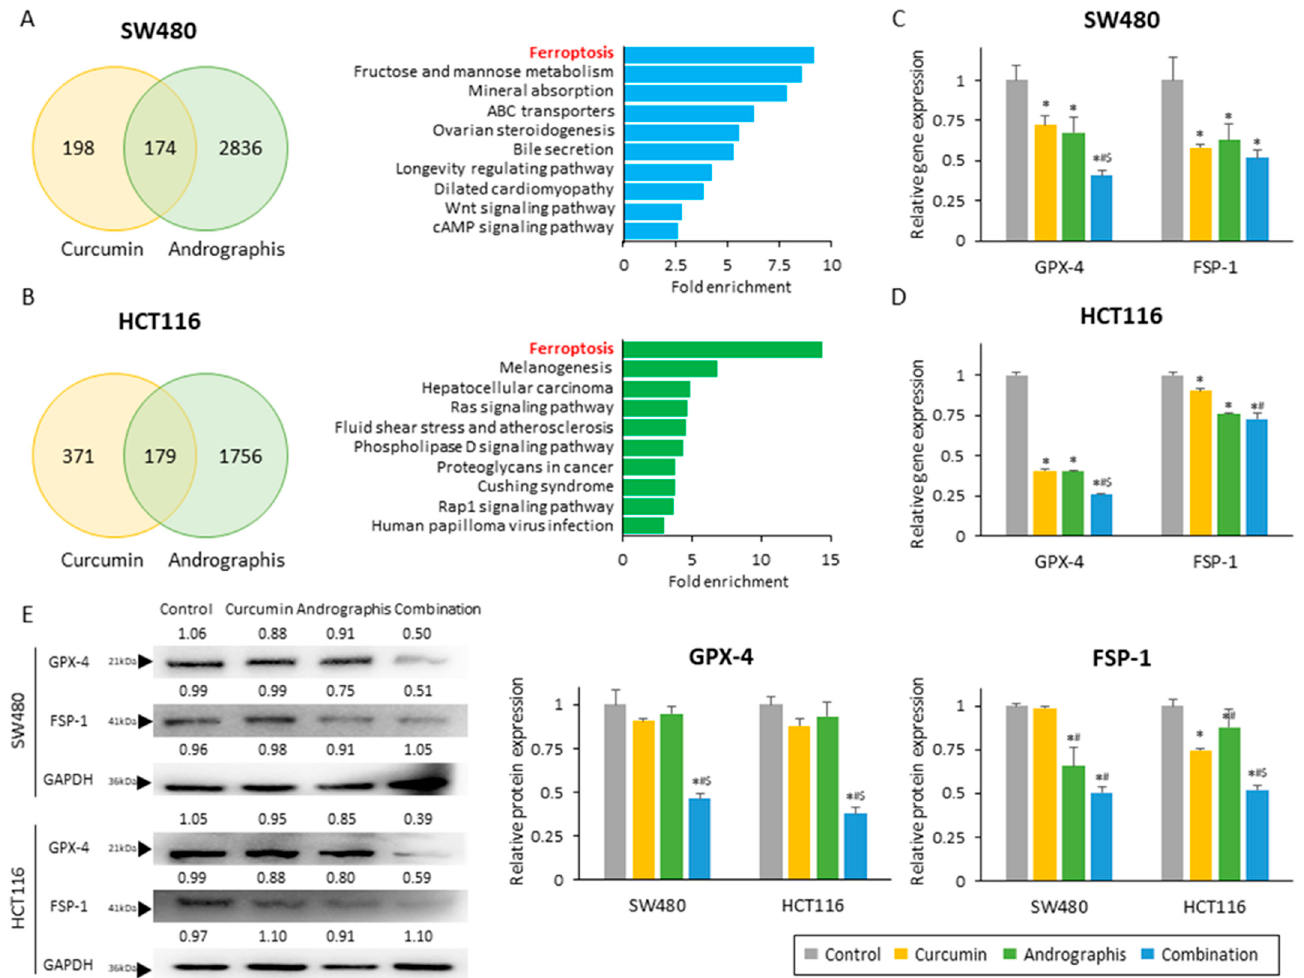
Figure 3. Curcumin and andrographis activated the ferroptosis pathway via dual suppression of GPX-4 and FSP-1. ( A ) Venn diagram of differentially expressed genes (|log FC| > 0.5, p < 0.05) and top 10 modulated pathways following treatment with curcumin and andrographis in SW480. ( B ) Venn diagram of differentially expressed genes (|log FC| > 0.5, p < 0.05) and top 10